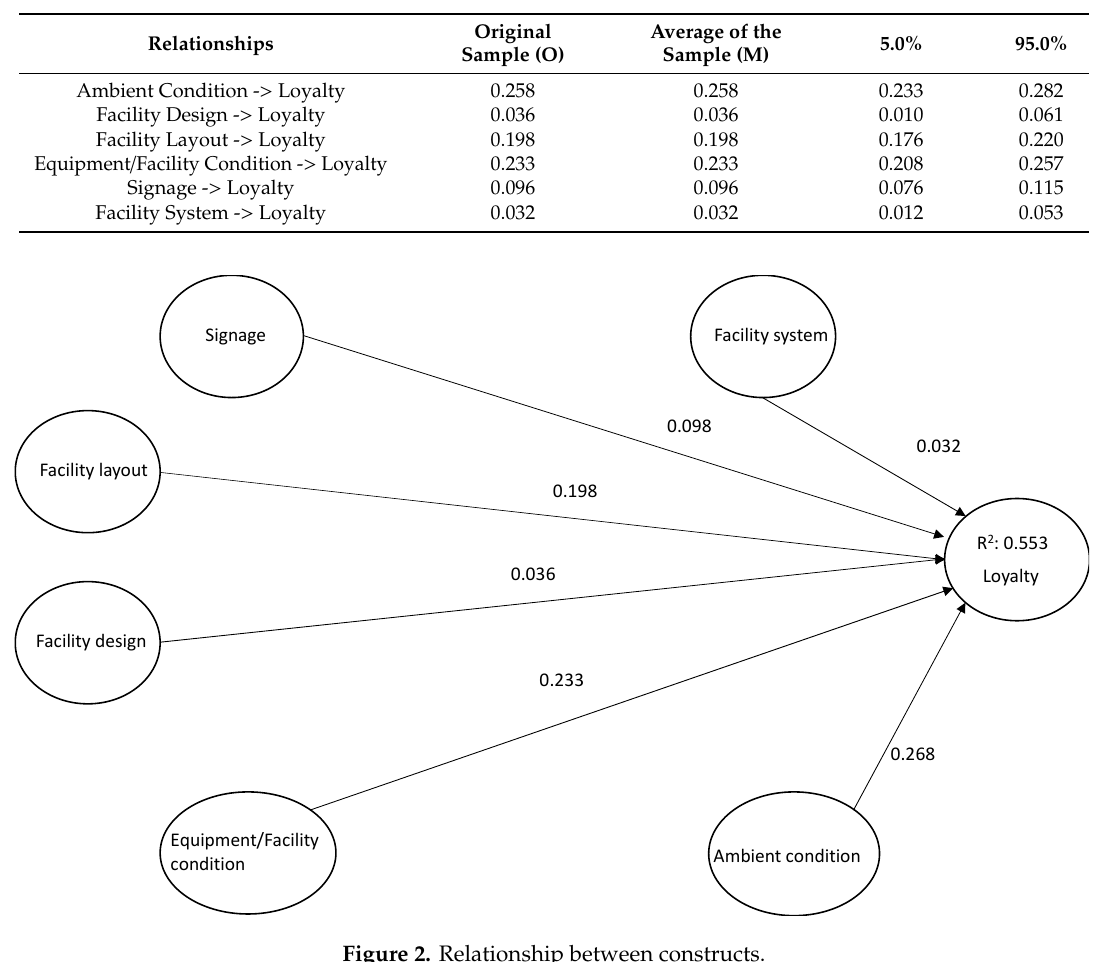
Table 5. Construct e ff ects on endogenous variables (incl. lower and upper limits of 95% confidence interval).